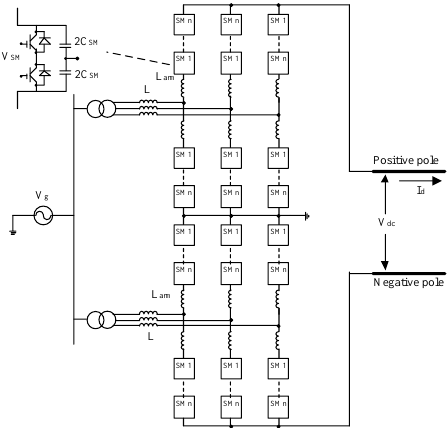
Figure 1. A converter station with modular multilevel converter (MMC) configuration.